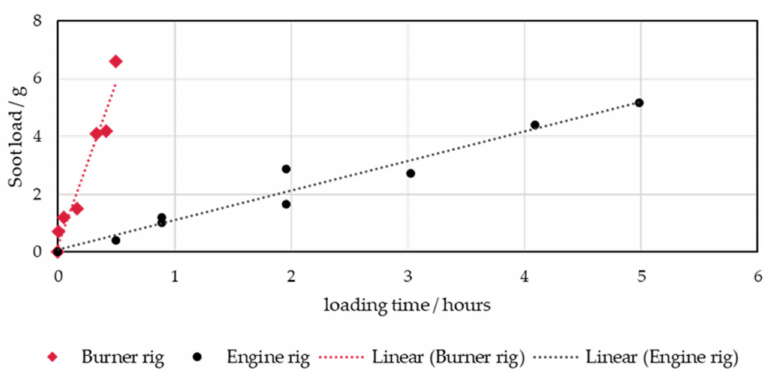
Figure 12. Soot load depending on loading time. Engine test bench vs. burner test bench.